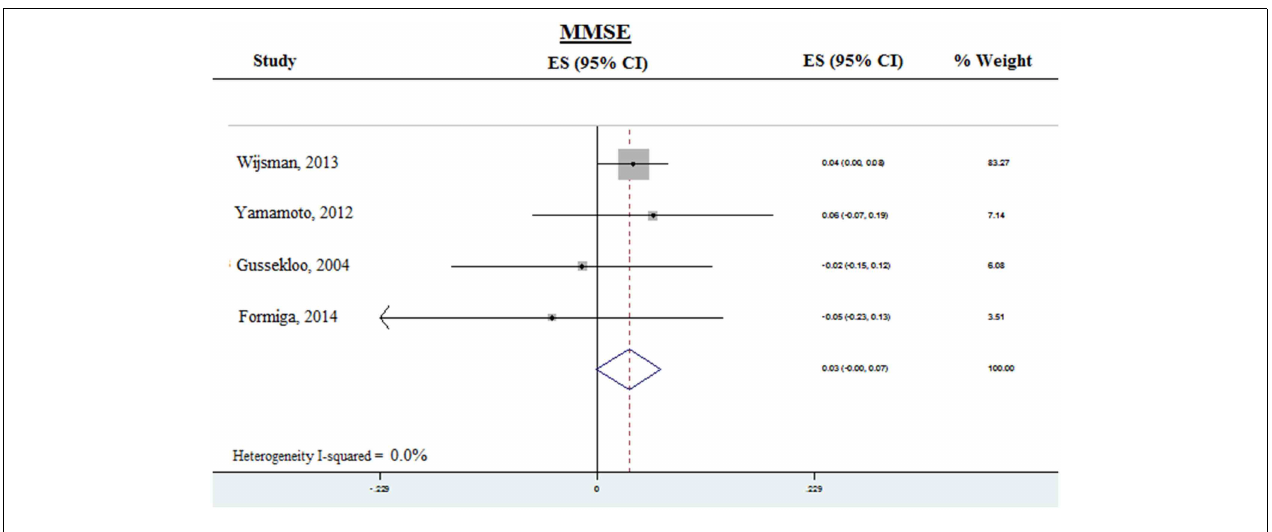
according to the weight of the studies. The pooled effect sizes are displayed as diamonds. MMSE, Mini-mental state